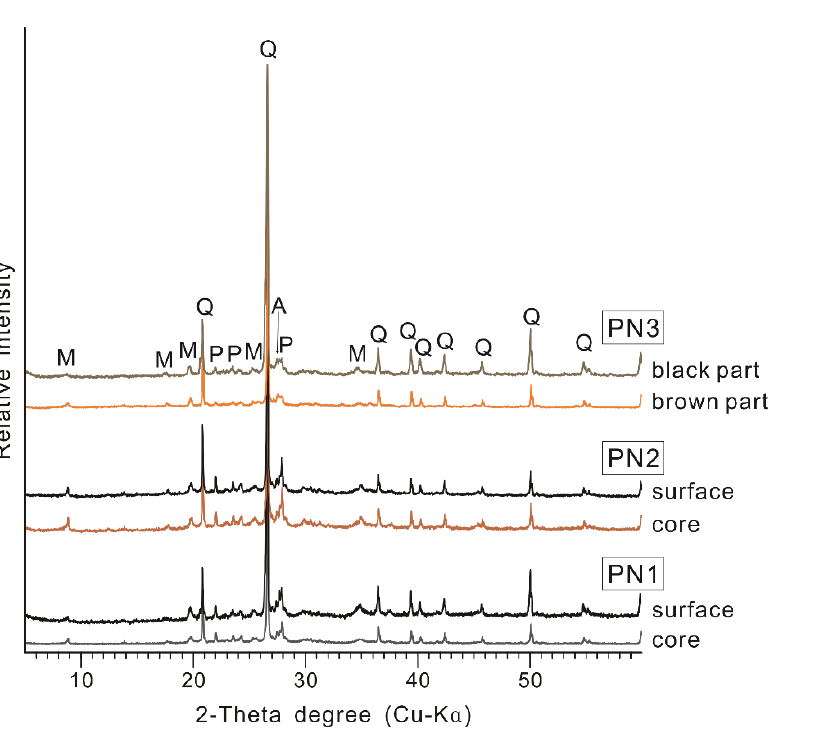
Figure 3. X-ray diffraction patterns of bulk powder samples (A: alkali feldspar, M: mica mineral, P: plagioclase, Q: quartz).